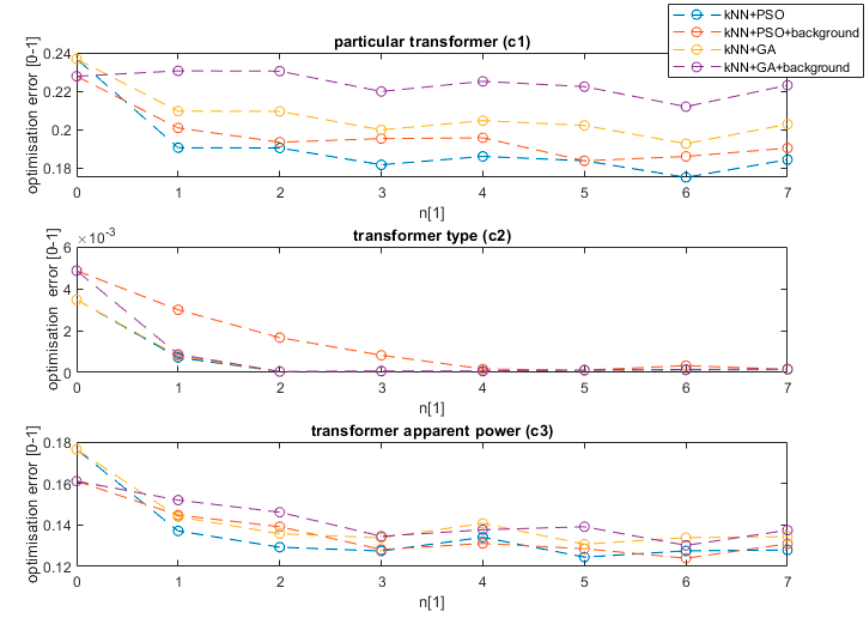
Figure 8. The training results for the optimization algorithm number of intervals n and feature c 1 , c 2 , and c 3.